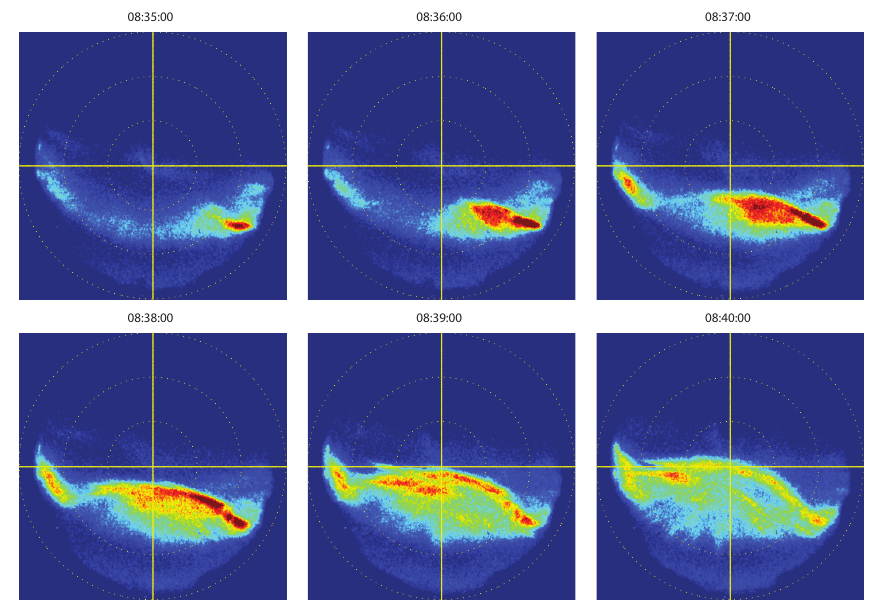
Fig. 11. ASC data from Ny ˚Alesund for the interval 08:35–08:40 UT. Same format as in Fig. 3. The central vertical line (yellow) marks the 12:00 MLT meridian. The ASC FOV at 630.0nm is marked in Fig.